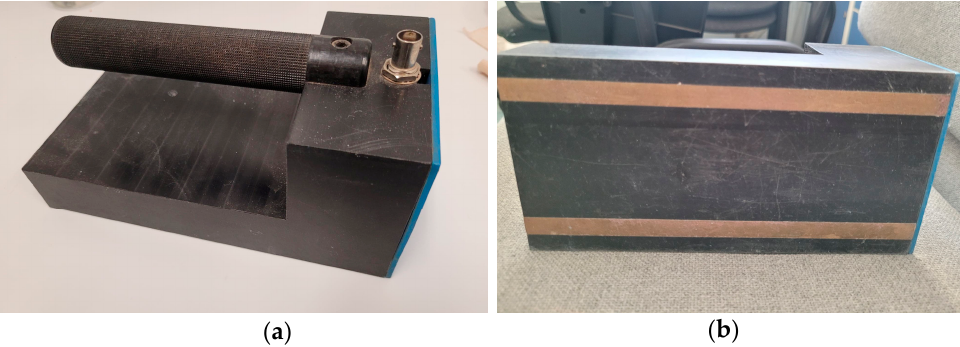
Figure 3. S2 non-invasive TDR sensor [42]. ( a ) Isometric view, ( b ) view from the bottom .